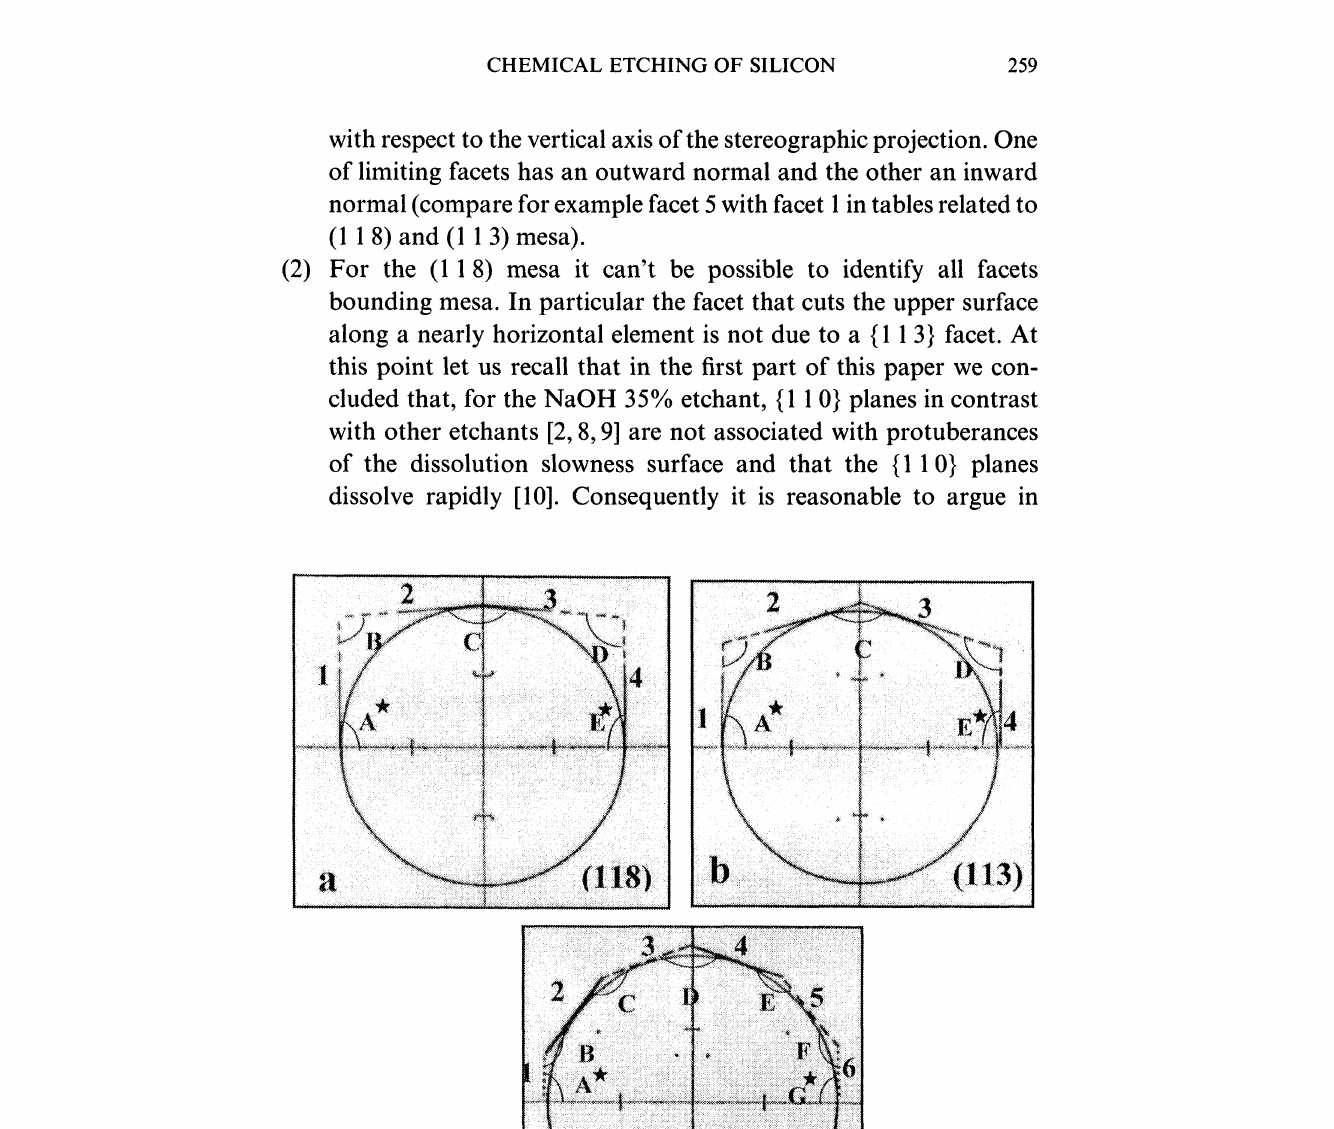
FIGURE 13 The top contour for various "circular" (hh/) or (h k0) membranes as derived from the stereographic analysis, a, b and e are for (1 3), (1 18) and (3 50) structures